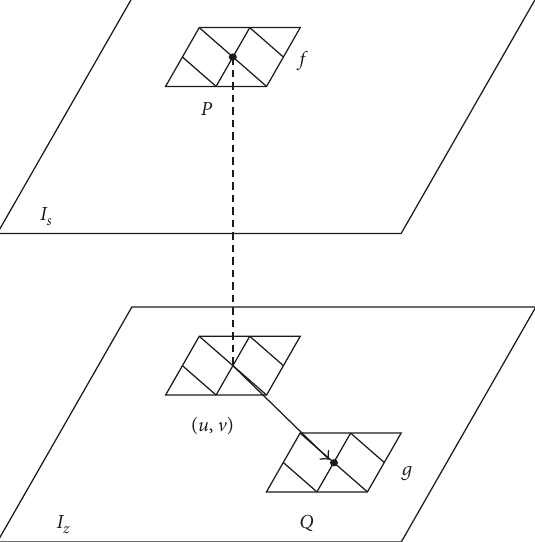
Figure 9: Sketch map of correlation